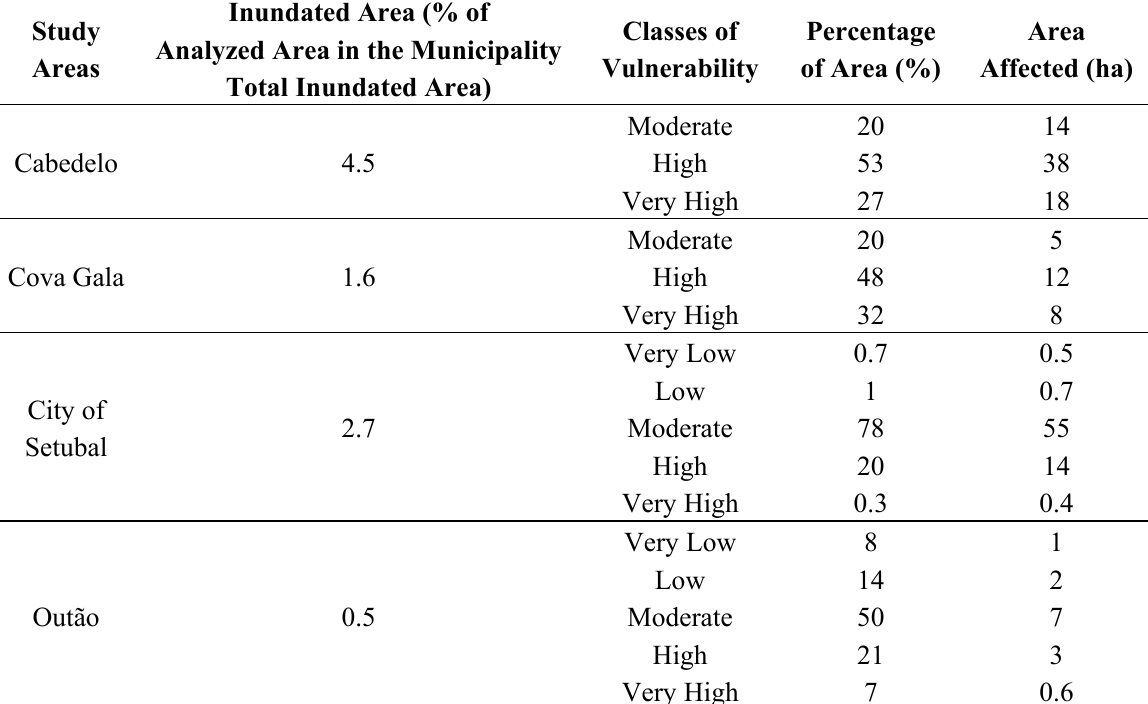
Figure 14. Morphological vulnerability: ( a ) Cabedelo; ( b ) Cova Gala; ( c ) City of Setúbal; ( d ) Outão; ( e ) Industrial zone; and ( f ) Martinhal. Table 5. Percentage of area by classes of